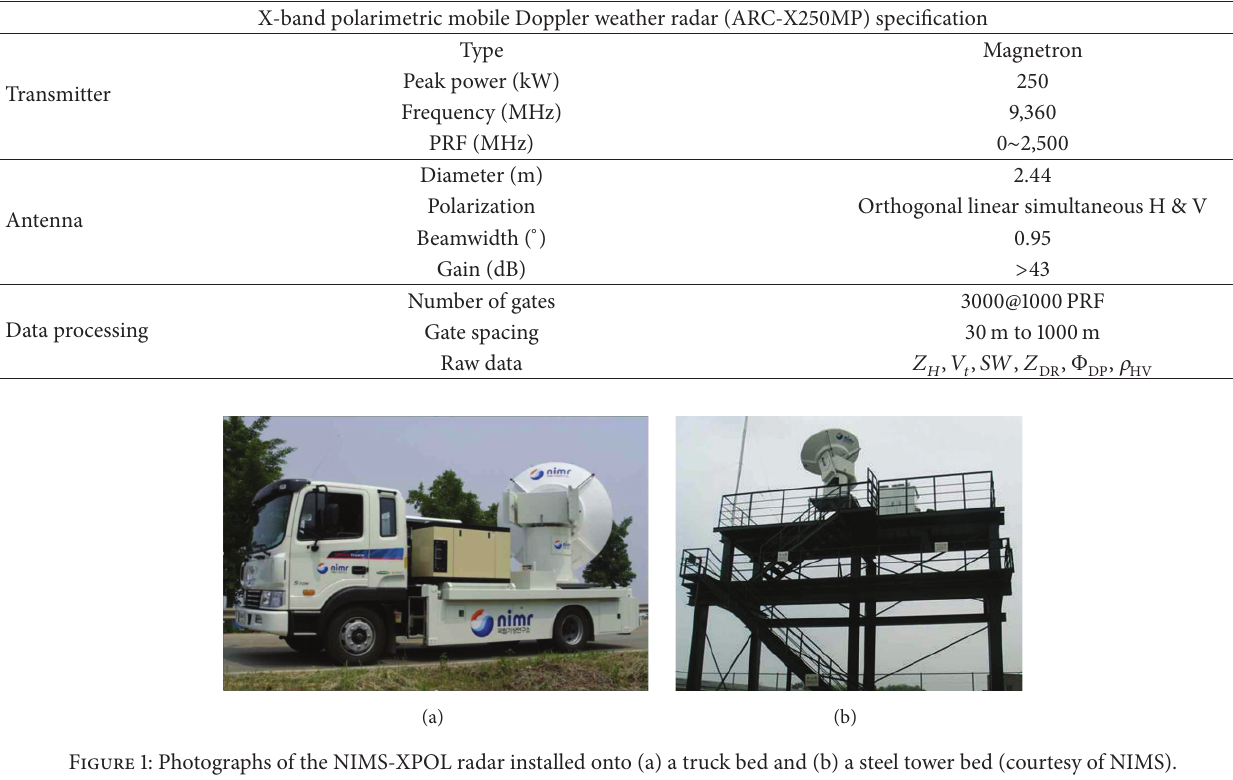
Table 1: General characteristics of the NIMS-XPOL radar [21].